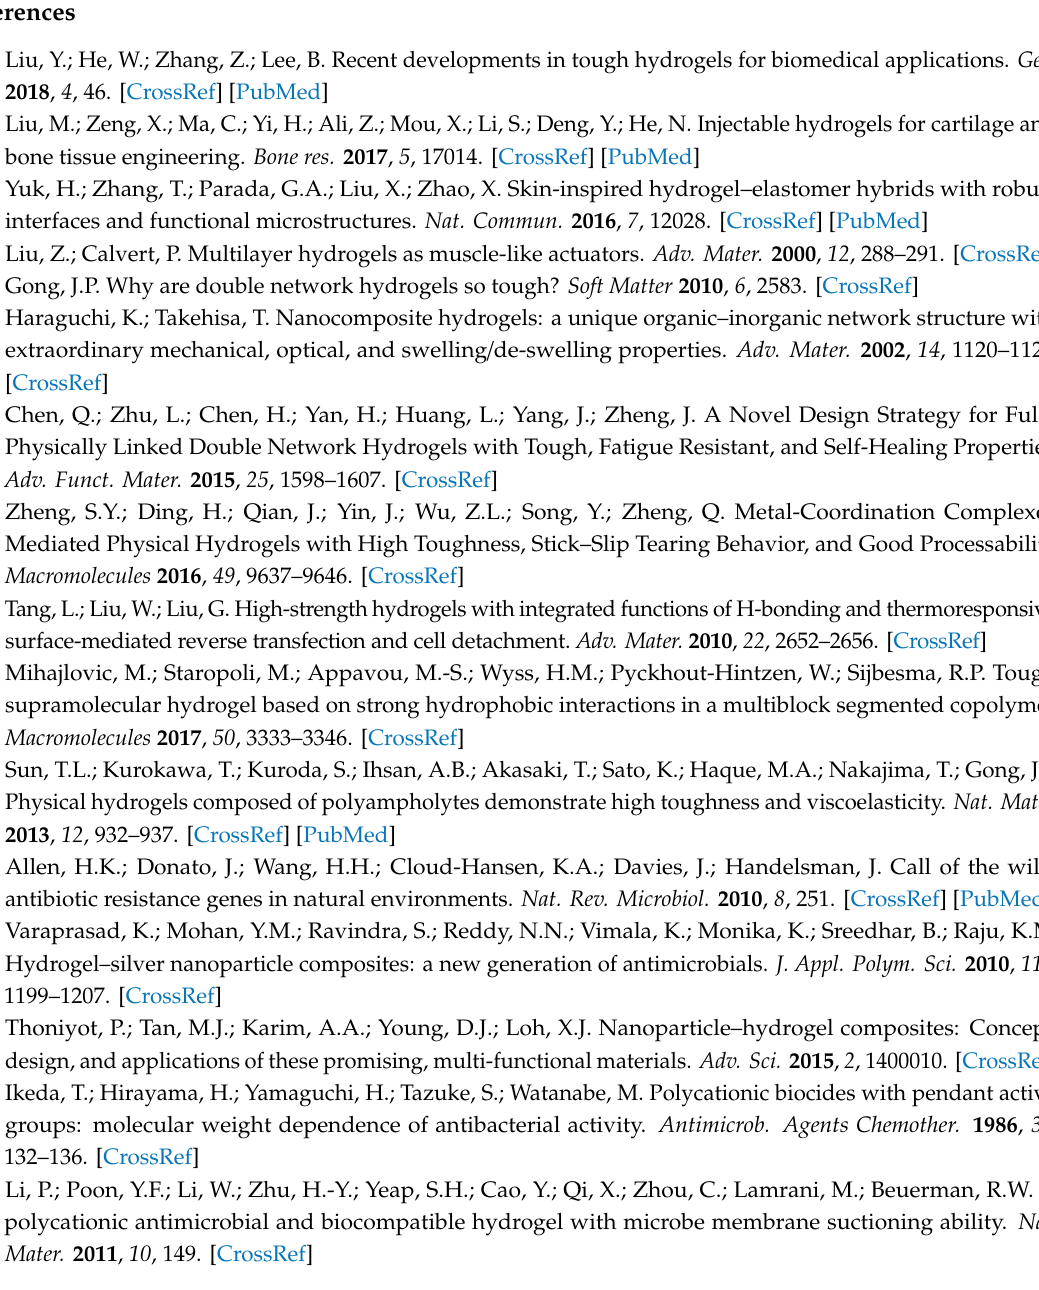
Figure S1: 10 successive loading-unloading cycles of the hydrogel at the deformation of 60% and 70% compressive strain. The compressive test was set at a deformation rate of 6 mm / min at room temperature; Figure S2: Compressive stress-strain curves of as-prepared pTMAEMA and as-prepare pTMAEMA-PA after rinsing with DI water, PBS 1 × and NaCl 4 M. The compressive test was set at a deformation rate of 0.5 mm / min at room temperature; Figure S3: PA release profile of pTMAEMA-PA incubating at 37 ◦ C in PBS solution shaking at 100 rpm; Figure S4: The cell viability of NIH-3T3 fibroblasts co-incubating with pTMAEMA and pTMAEMA-PA-0.1 in the indirect cytotoxicity